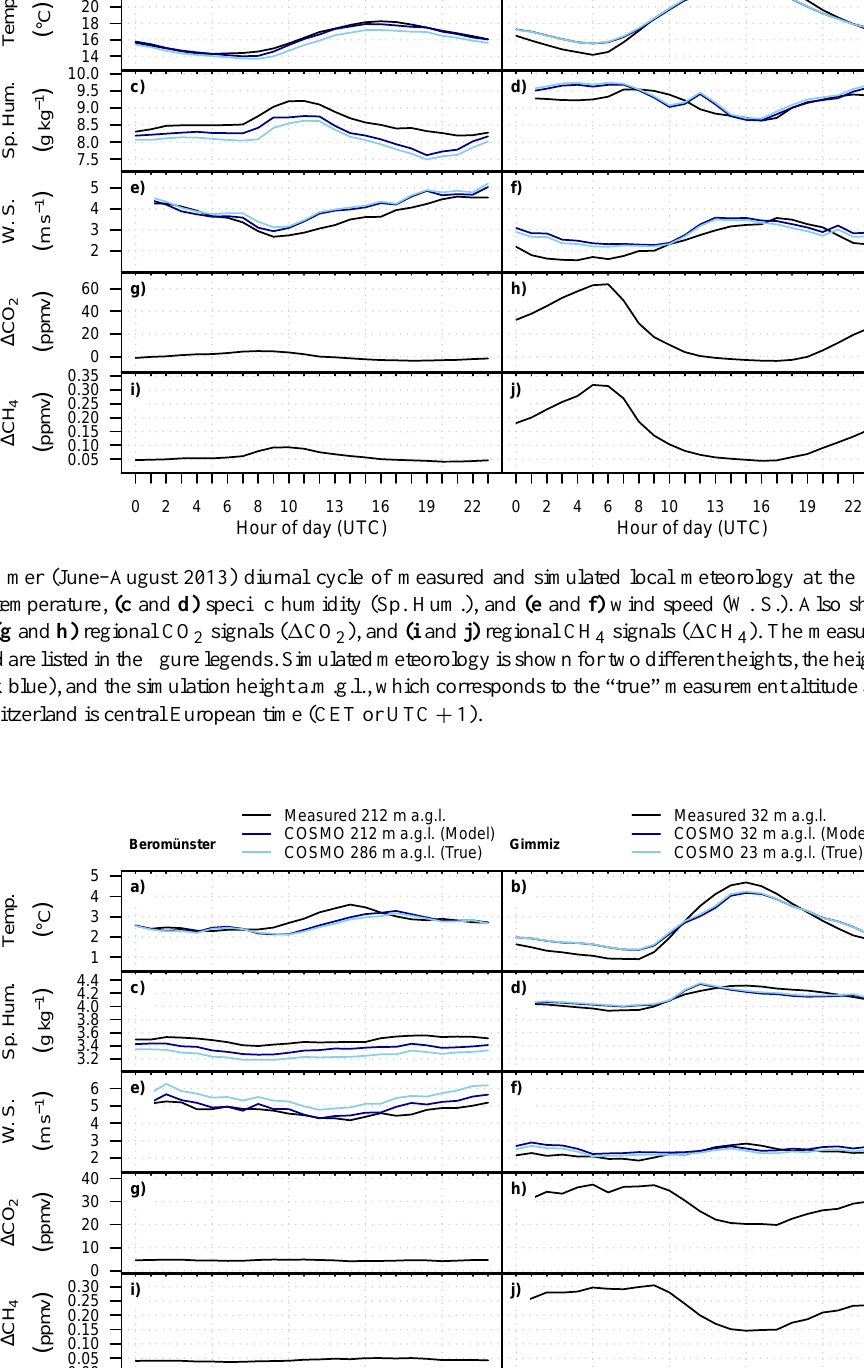
Atmos. Chem. Phys., 15, 11147–11164,